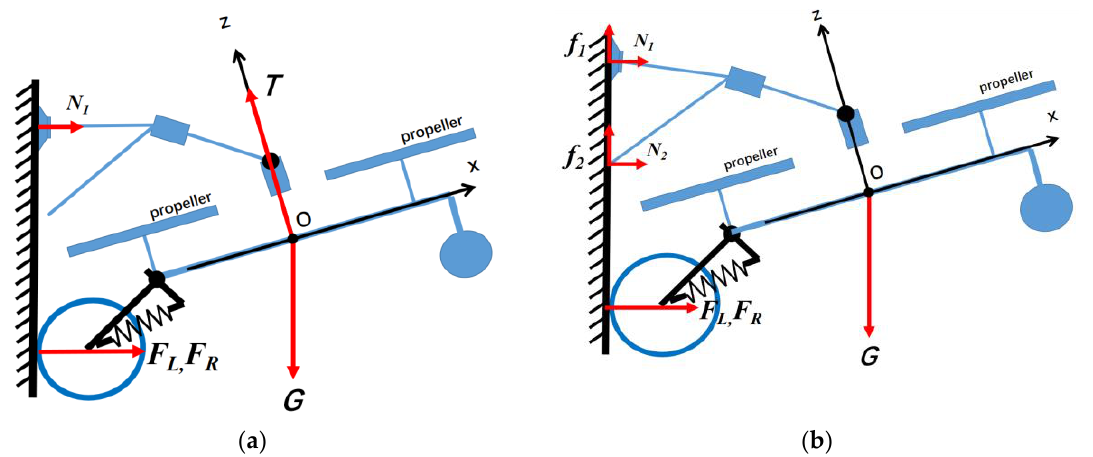
Figure 6. Force analysis of the robot. ( a ) Force analysis of the approaching state (propellers are working). ( b ) Force analysis of the adsorbing state (propellers are not rotating).